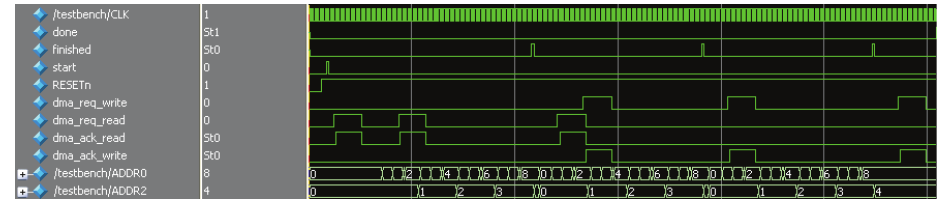
Figure 12: ModelSim